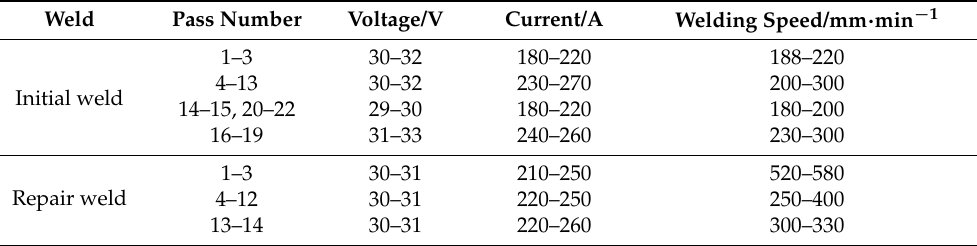
Figure 2. Welding sequence and dimensions of the repair weld. ( a ) Welding sequence; ( b ) dimensions. Table 2. Welding parameters.